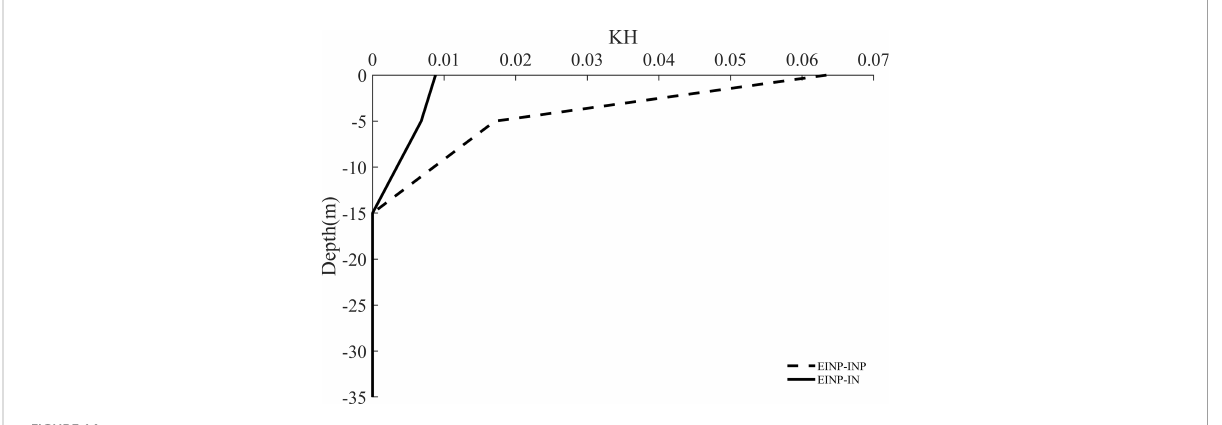
FIGURE 14 Vertical pro fi les of the simulated averaged the vertical mixing coef fi cient for temperature KH (m 2 s -2 ) from EINP-IN and